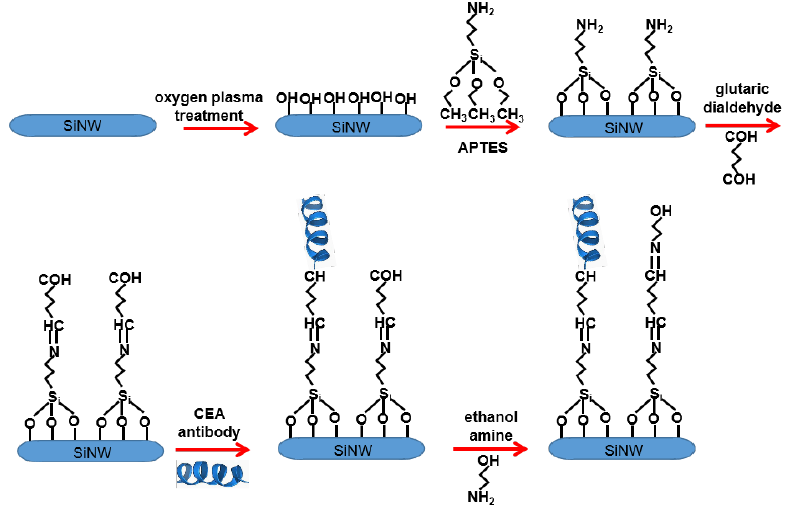
Figure 2. The process of surface modification of the SiNW array.